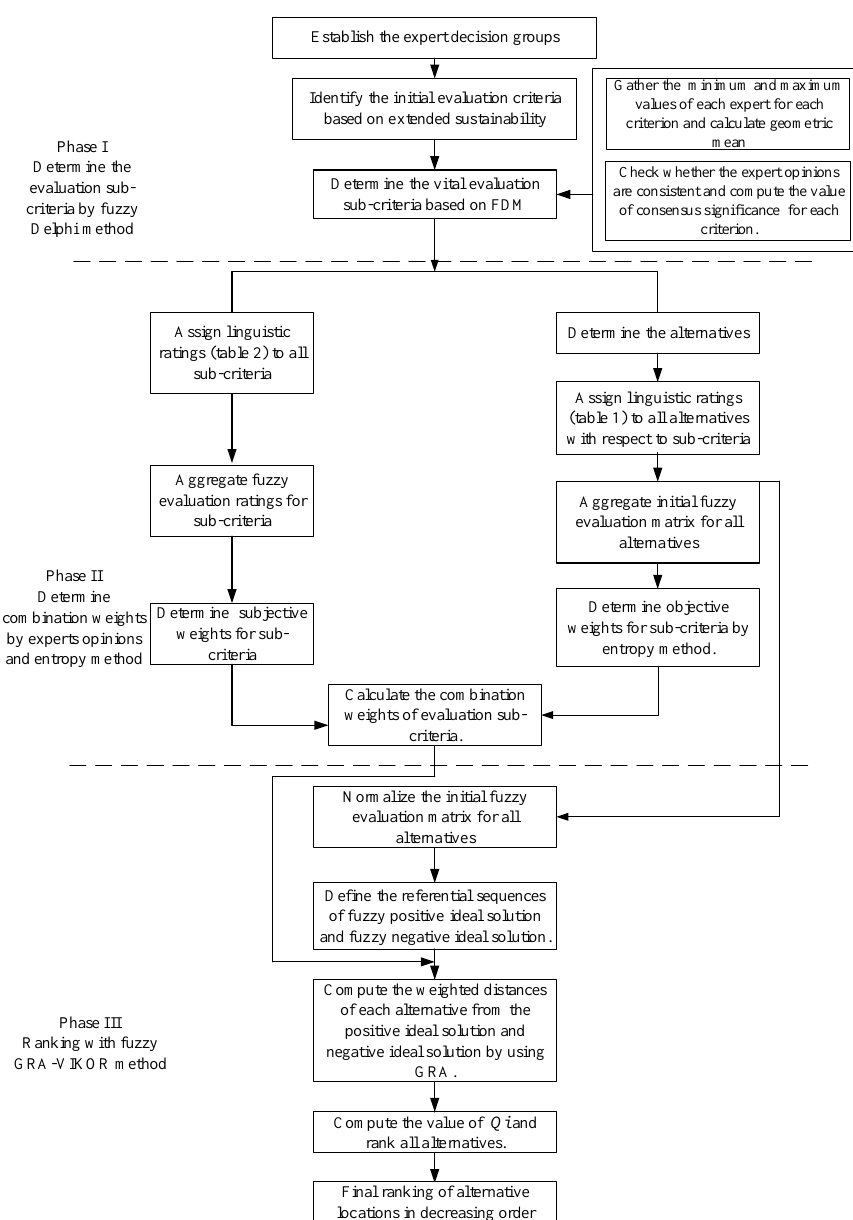
Figure 1. The framework of the proposed model for optimal siting of charging stations for electric vehicles. Phase 1: Identify the vital evaluation sub-criteria based on extended sustainability and FDM